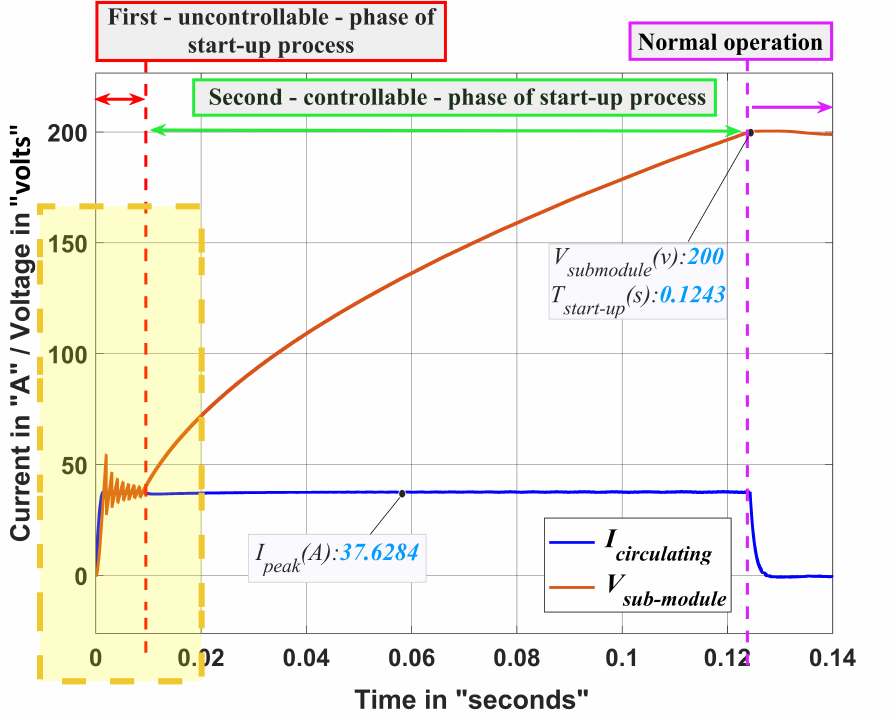
Figure 5. The proposed start-up precharging method applied to a single-phase MMC having the capacitor bank topology with 8 stages.